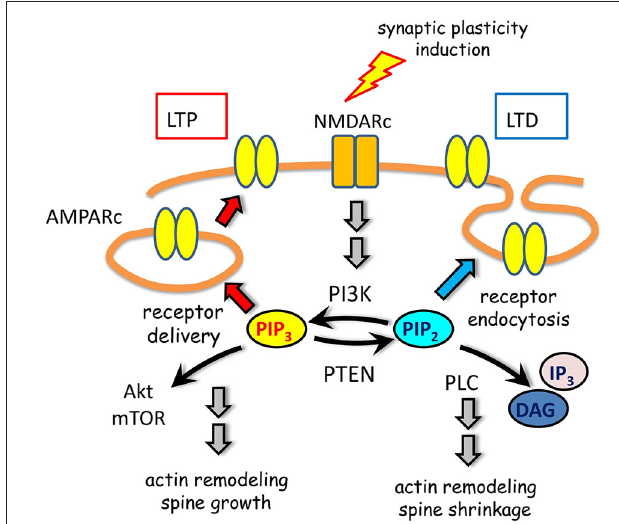
FIGURE 3 | PIP metabolism in spine plasticity . Activation of NMDARc modulate AMPARc trafficking through spatially and timely controlled activity of PIPs and their metabolic enzymes. On one hand, PI3K association with AMPARc is required for receptor cell surface delivery during LTP. On the other hand, PTEN activity leading to PIP3 downregulation promotes migration of AMPARc from the postsynaptic density to the perisynaptic membrane. This depresses AMPARc synaptic responses by promoting receptor endocytosis during LTD. Moreover, signaling pathways initiated by PIP3 or PIP2, in which Akt/mTOR, DAG and IP3 are involved, contribute to actin remodeling and spine changes in